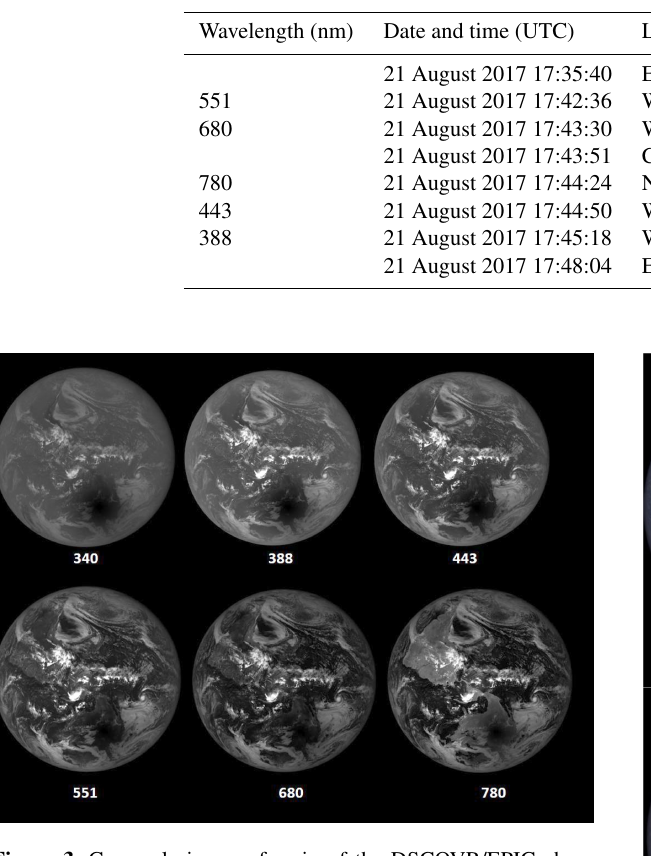
Figure 3. Grayscale images for six of the DSCOVR/EPIC chan- nels for the eclipse over Casper, Wyoming, showing the blurring caused by Rayleigh scattering and the dark land and ocean surfaces at 340nm to the almost clear atmosphere and bright continental sur- faces at 780nm. The images were obtained over a period of 2.7min. North is facing down. The gray scale is linear, with black repre- senting very low reflectivity and white very high reflectivity from high-altitude equatorial region clouds. Figure 4. (a) Synoptic natural color images on 21 August at 16:14